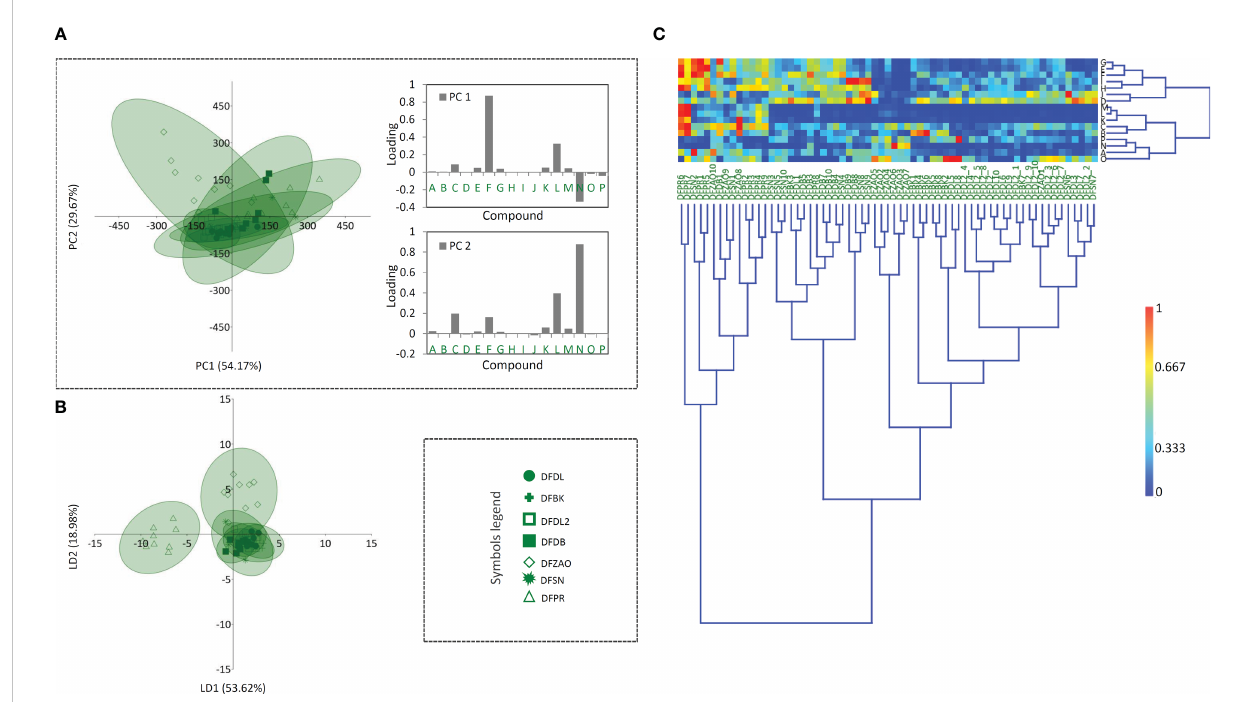
FIGURE 6 Principal component analysis (PCA) biplot with the fi rst two PCs explaining 83.84% of the total variance (A) among D. ferruginea accessions. For seven D. ferruginea populations (each labeled by a different symbol) 95% con fi dence ellipses are presented. Participation of the variables (compounds) in the fi rst two PCs is indicated by the corresponding loading plots. Linear discriminant analysis (LDA) (B) represents the same seven populations of D. ferruginea with 95% con fi dence ellipses. Heatmap of the scaled quantitative data (C) with the samples arranged according to the hierarchical cluster analysis (Ward ’ s method of cluster agglomeration). Compounds ’ labels are the same as in Figure 3. For the interpretation of population abbreviations in the fi gure legend, please refer to Table